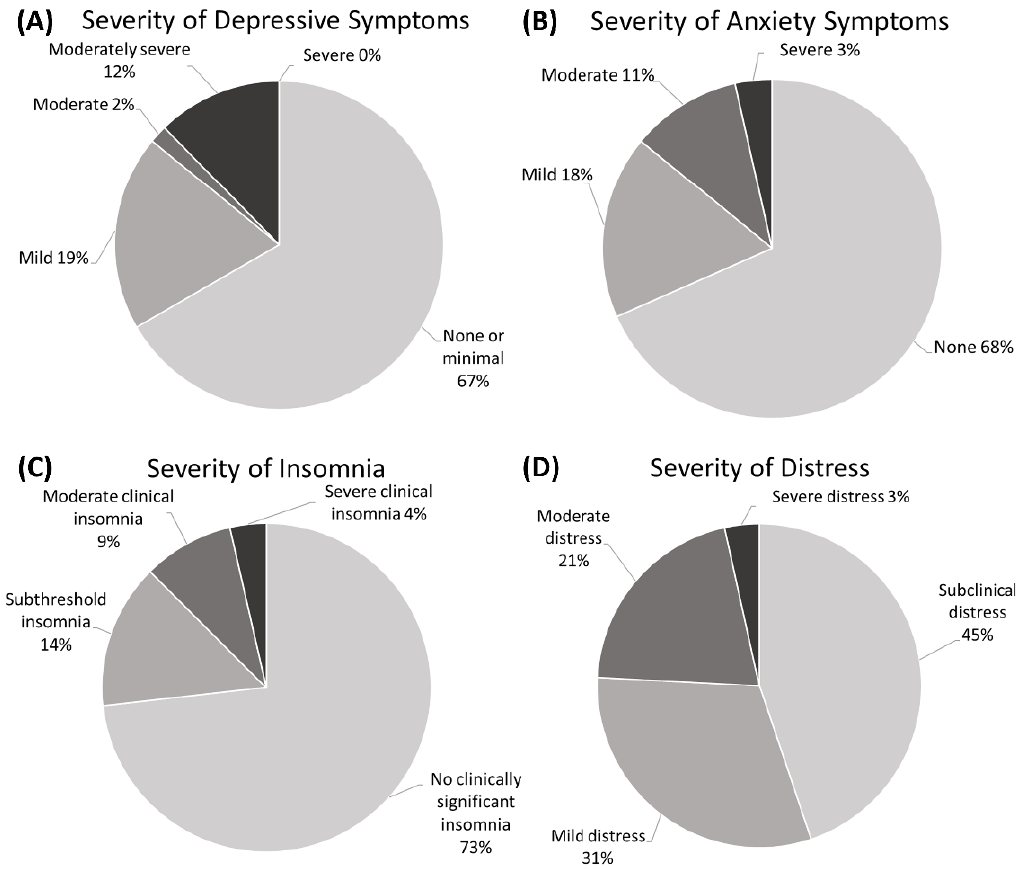
Figure 1. Pie charts illustrating the proportion of respondents with varying severities of mental health symptoms according to the ( A ) Patient Health Questionnaire-9, the ( B ) Generalized Anxiety Disorder-7 scale, the ( C ) Insomnia Severity Index, and the ( D ) Impact of Event Scale-Revised score. Results for the GAD-7 scale had a median score of 2 (0,6) (range: 0–18). A majority ( n = 39, 70%) had no significant anxiety, while 10 (18%) had mild anxiety, 6 (11%) had mod- erate anxiety, and 2 (4%) had severe anxiety. One respondent (2%) was deemed to have impaired functioning due to their anxiety symptoms.